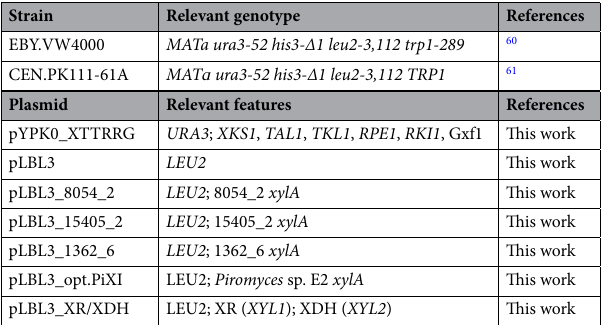
Table 2. Saccharomyces cerevisiae strains and plasmids used in this